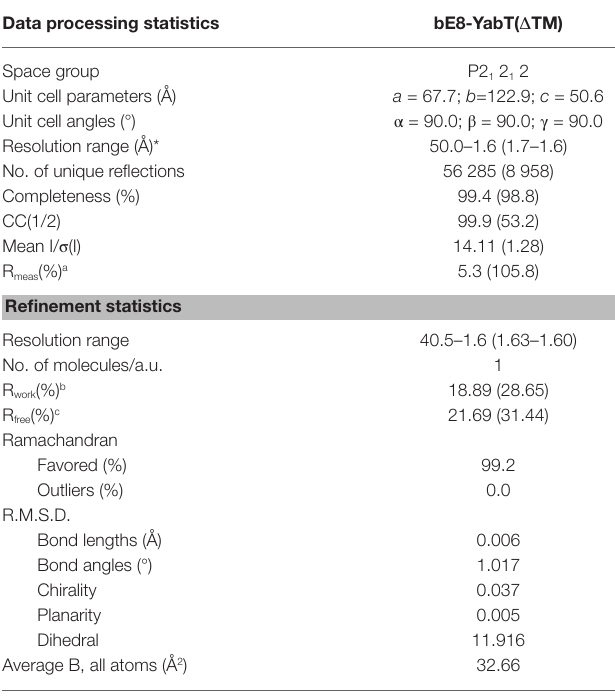
TABLE 1 | X-ray diffraction data processing and refinement statistics.